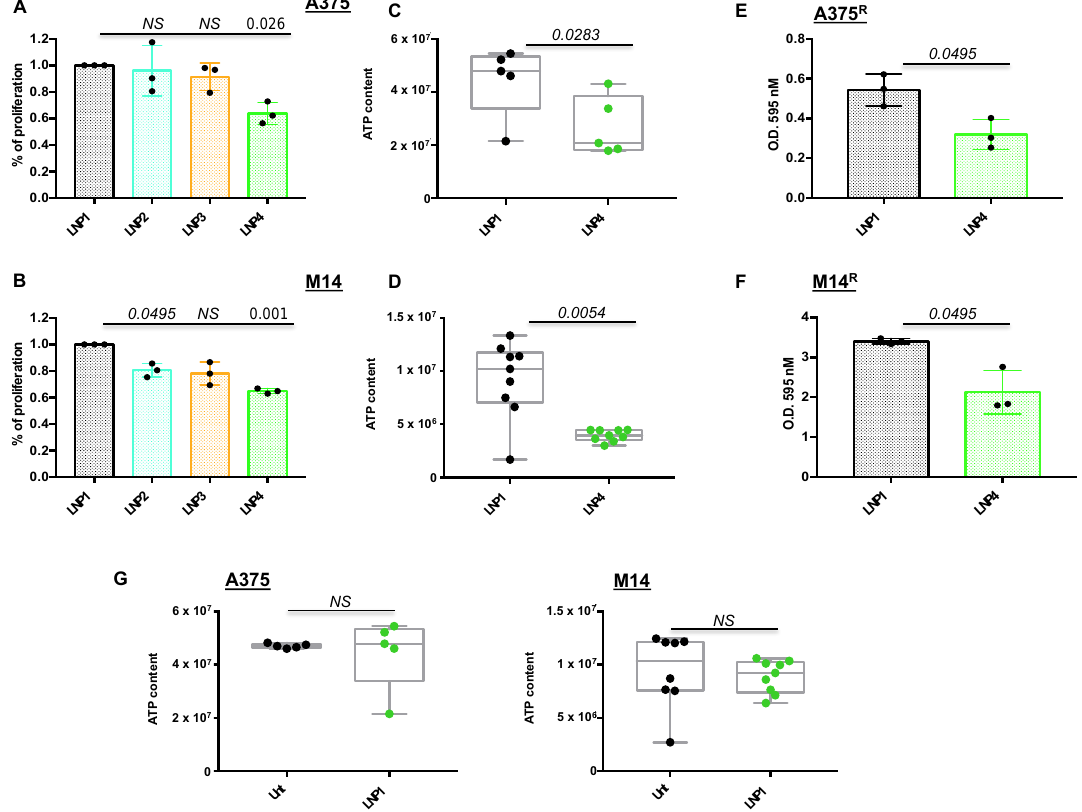
Figure 1. Lipid nanoparticles carrying oncosuppressive miRNAs inhibit melanoma cell proliferation. A375 ( A ) and M14 ( B ) melanoma cells were exposed to 30 μg of the indicated LNPs for 72 h: LNP1 (empty), LNP2 (miR-204-5p), LNP3 (miR-199b-5p) or LNP4 (miR-204-5p+miR-199b-5p). Viability was determined through crystal violet staining to obtain % of cell proliferation as compared to LNP1-treated cells. Cellular ATP was tested by luminescence assay to determine metabolic activity in response to LNP1 and LNP4 treatments in A375 ( C ) and M14 ( D ) cells. Crystal violet staining and O.D. at 595 nM reading by spectrometer assessed the growth inhibitory effects of LNPs in BRAFi-resistant cells (i.e., A375R ( E ) and M14R ( F )). Cellular ATP measure, performed as described above, was used to test the effects of empty LNPs as compared to untreated A375 and M14 cells ( G , left and right panels).